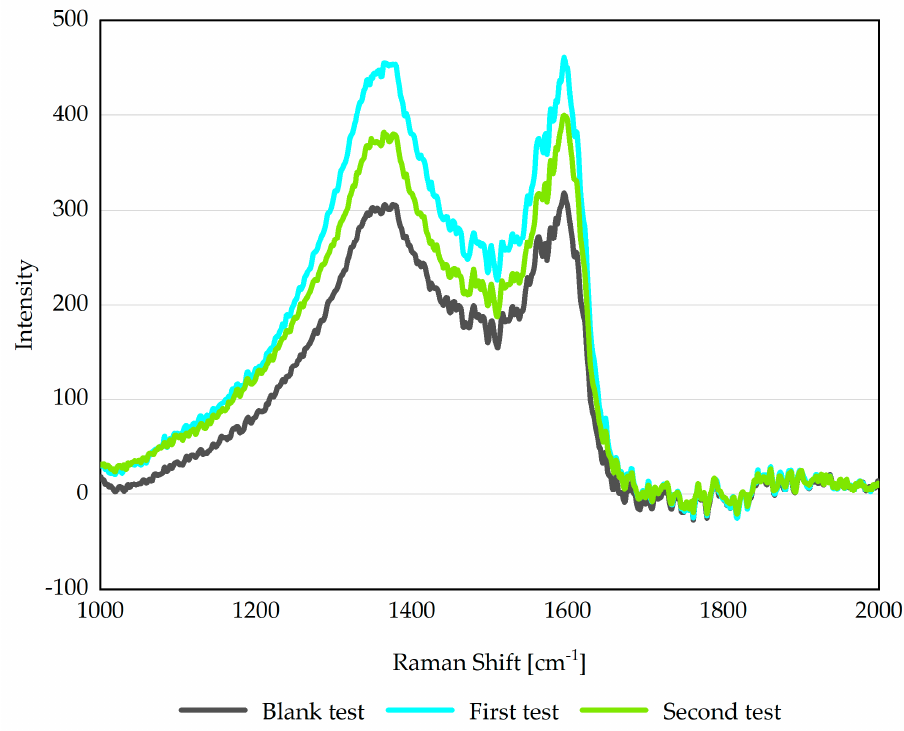
Figure 25. Raman spectra of the spontaneous and accelerated deactivated